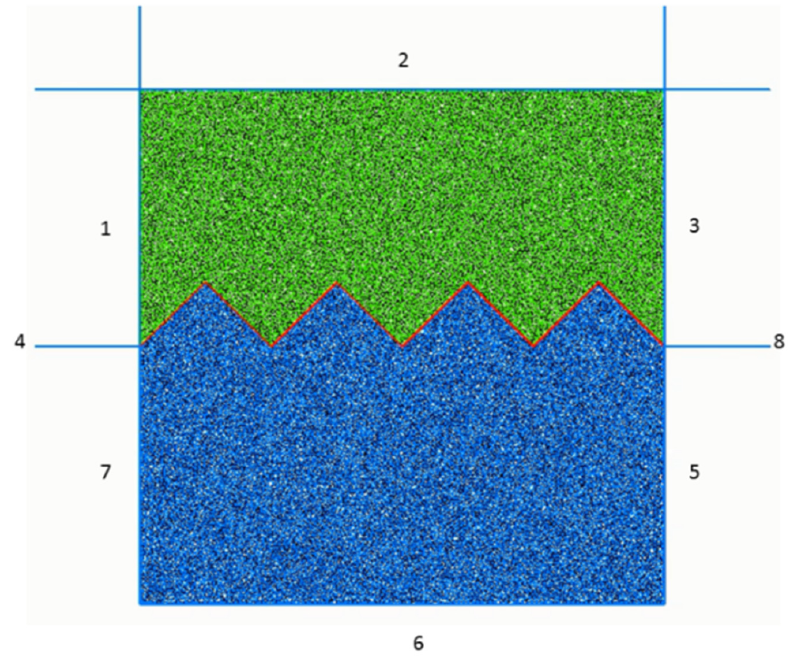
Figure 2. The numerical mode of PFC2D in a serrated structural plane (1–8 are the numbers of the walls respectively).